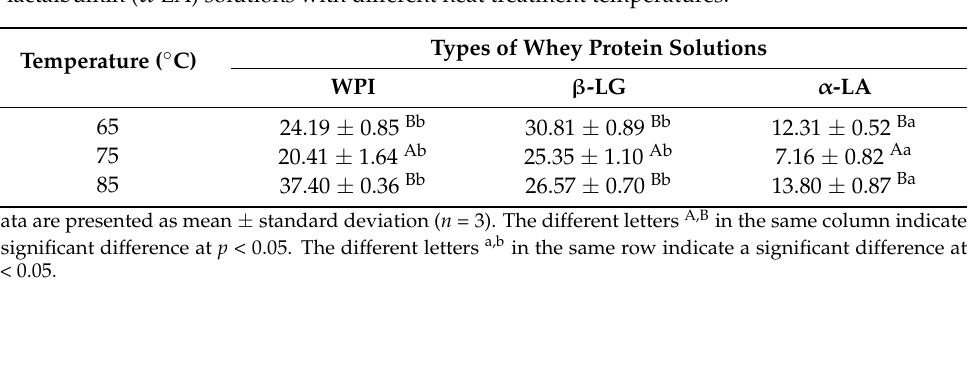
Table 2. The Dipeptidyl peptidase-IV half-maximal inhibitory concentration (DPP-IV IC 50 ) values (mg/mL) of protein hydrolysates from whey protein isolate (WPI), β -lactoglobulin ( β -LG), and α -lactalbumin ( α -LA) solutions with different heat treatment temperatures. Temperature (°C)